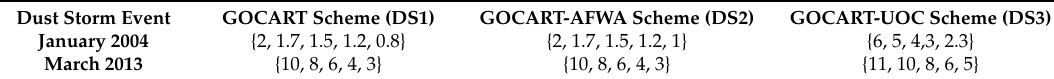
Table 4. Values of tunable coefficients used in the simulation of each one of the three dust schemes for each storm